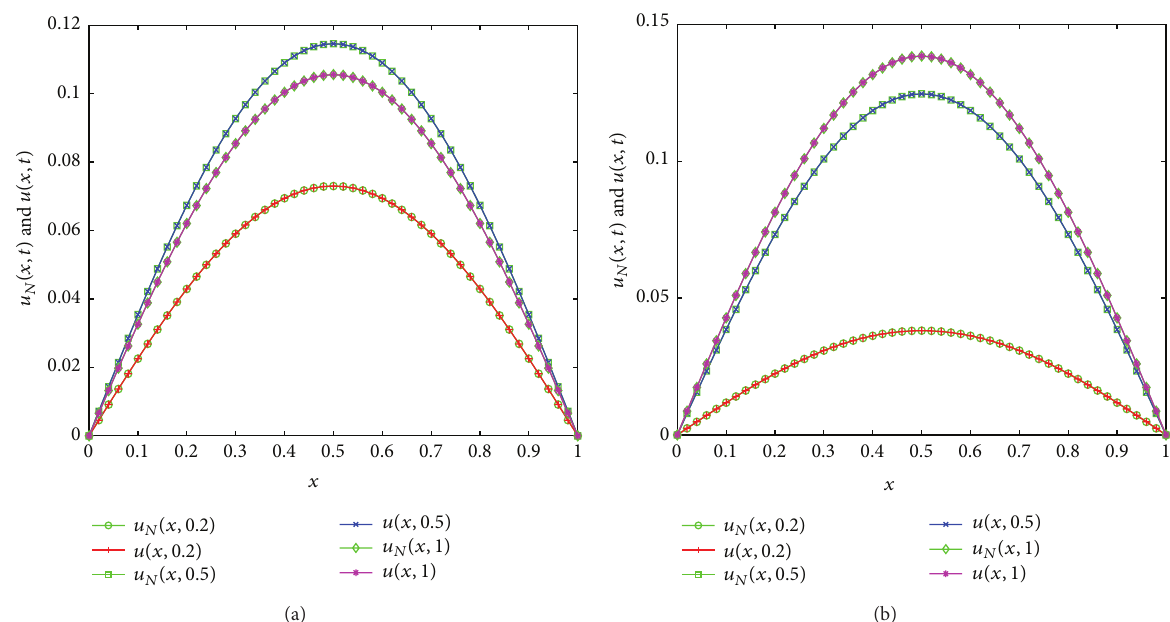
Figure 2: Comparison of the numerical and exact solutions for several fixed time instants with 𝛼 = 1.3 (a) and 𝛼 = 1.7 (b).